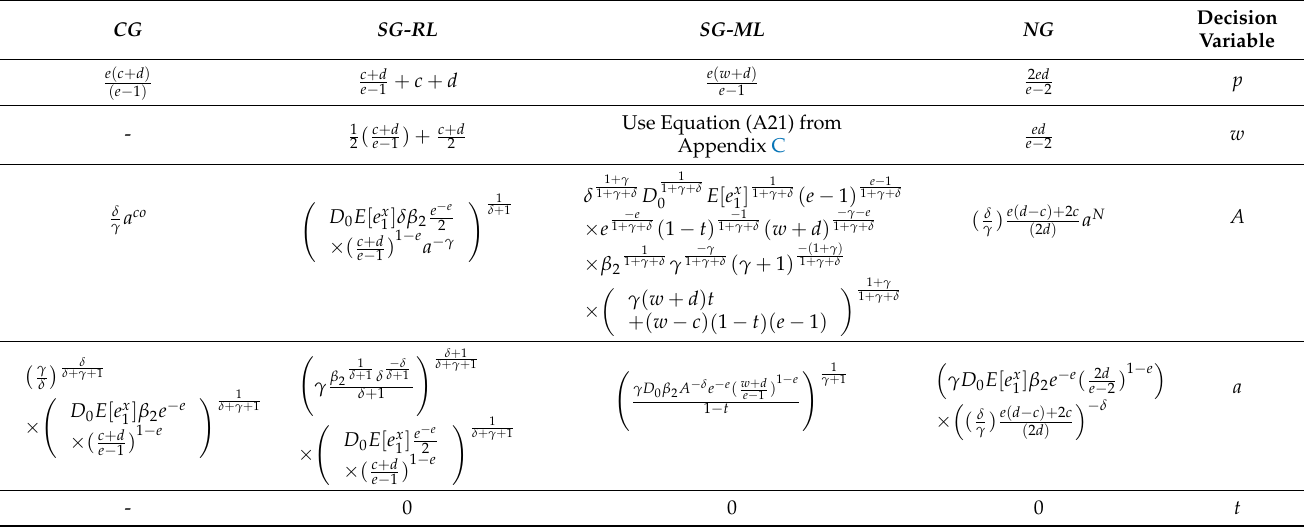
Table 1. Optimal values for the decision variables under the four strategies for the first model.